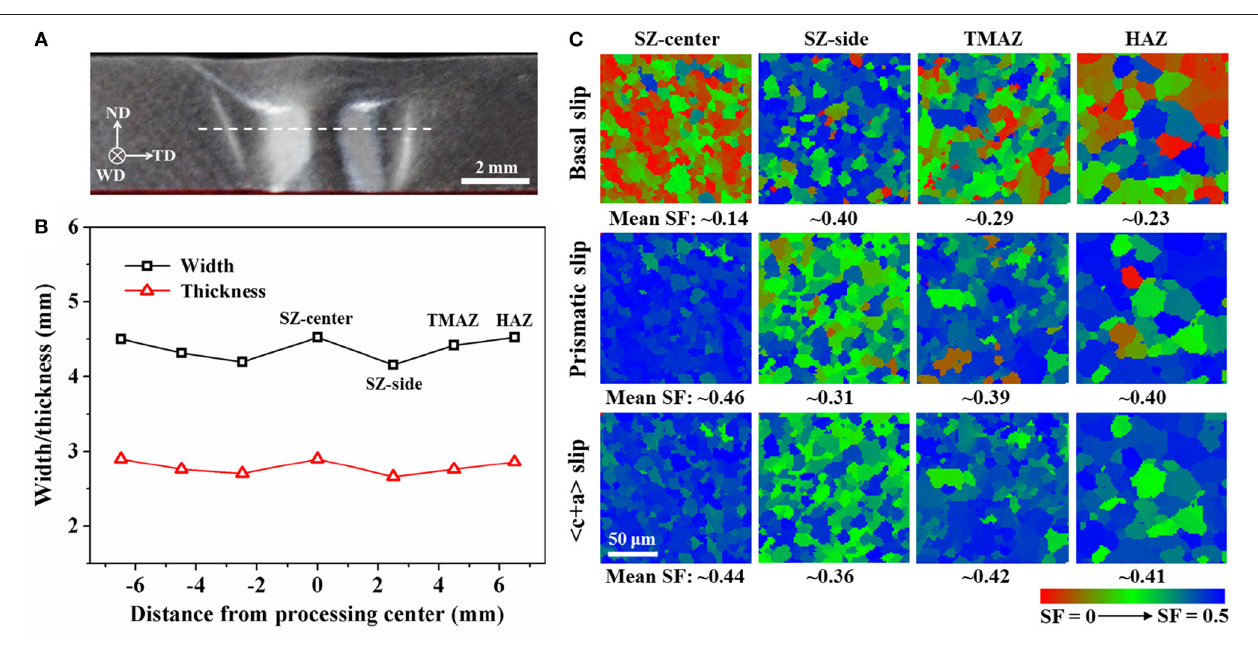
FIGURE 5 | (A) Macrograph of the Mg weld after transverse tensile test; (B) measured with width and thickness at different sub-regions of the FSP AZ31Mg alloy after tensile fracture. The original width and thickness of tensile samples were 5 and 3mm, respectively; (C) SF maps of the various regions of the Mg weld (Xin et al., 2012) (Copyright © 2012, Springer